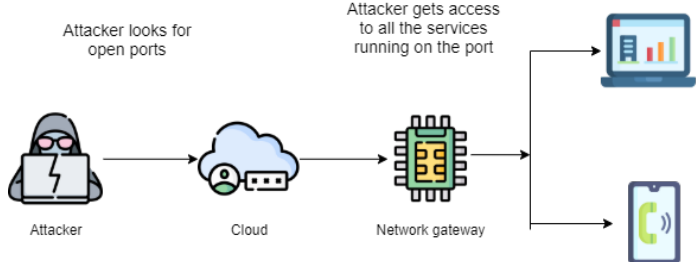
Figure 11. Graphical representation of a port scanning attack